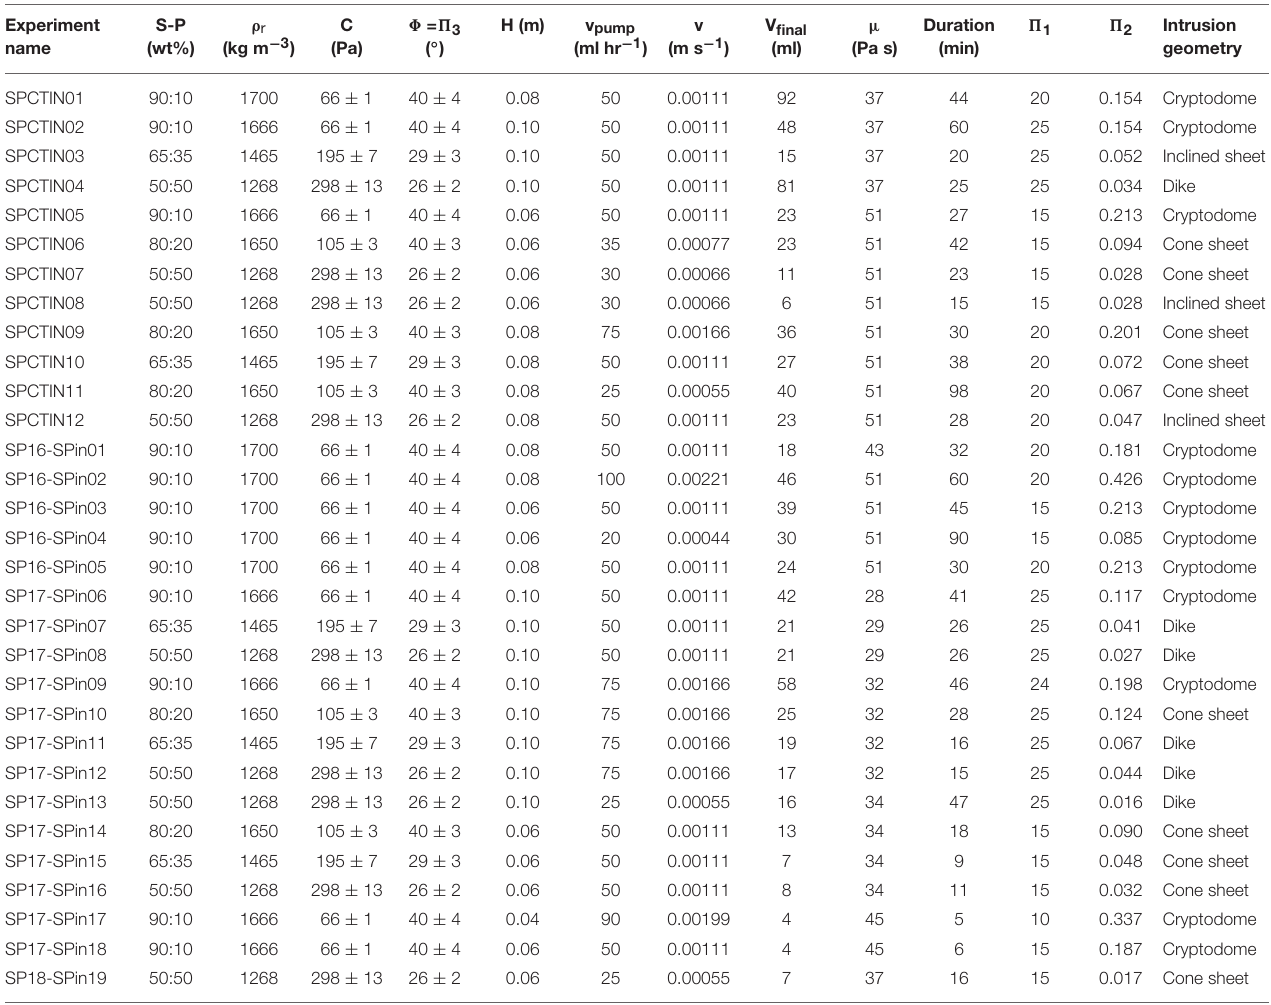
TABLE 2 | Set-up parameters and outcome of analog models of golden syrup intrusion in granular materials run in the UZ Brussel hospital CT scanner and in the laboratory; see Table 1 for abbreviations. Experiment